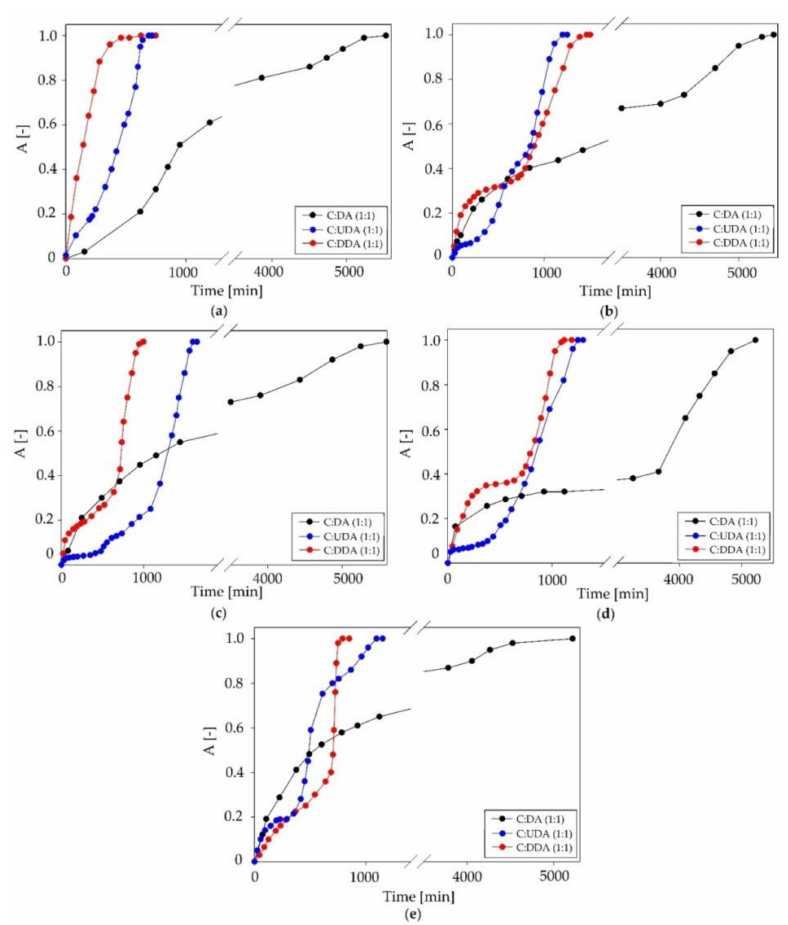
Figure 9. Absorption curves of the studied DESs for individual siloxanes: ( a ) L2, ( b ) L3, ( c ) L4, ( d ) D3 and ( e )